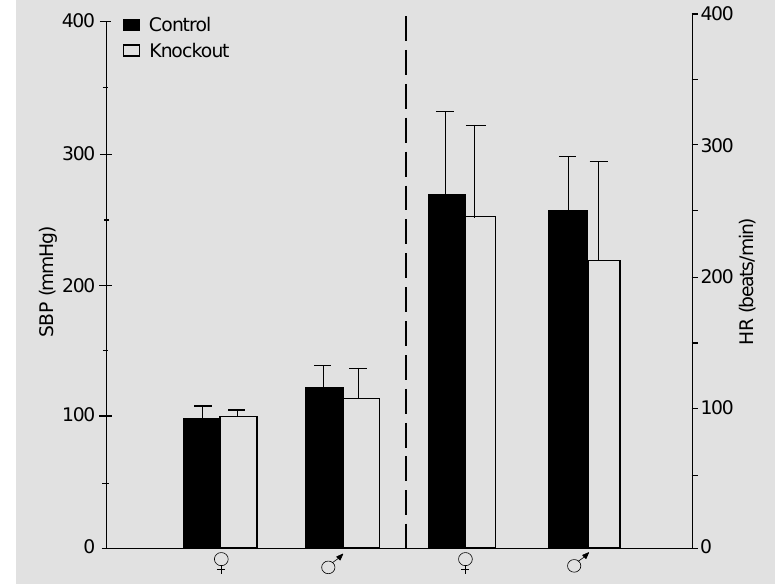
Figure 2 - Systolic blood pressure (SBP) and heart rate (HR) for control (closed bars) and Mas -deficient (open bars) mice of both